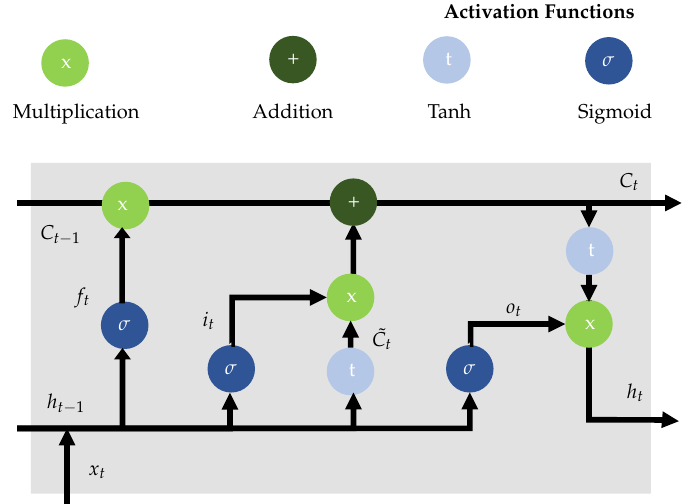
Figure 4. Architecture of an LSTM cell of a Recurrent Neural Network (RNN)